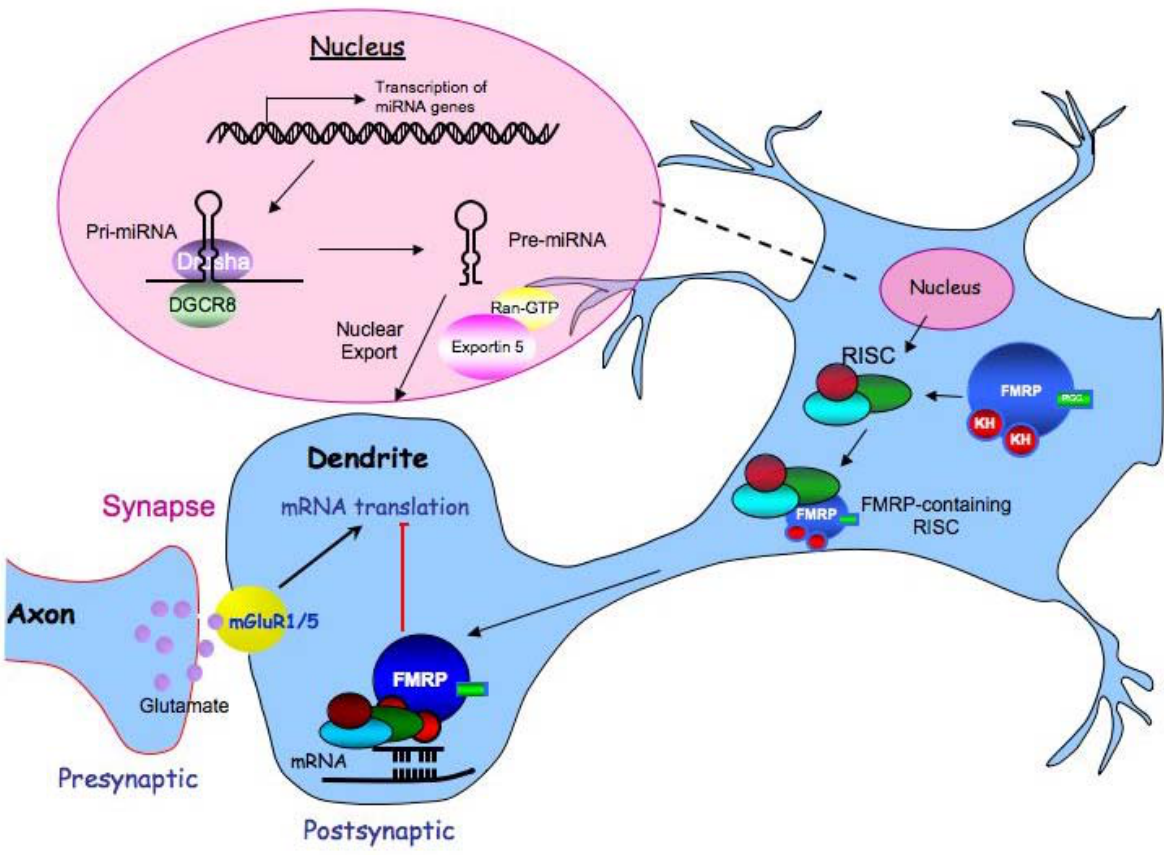
FIGURE 1. A model for FMRP-mediated translational suppression of mRNA targets via the miRNA pathway in the neuron. In the nucleus, miRNA genes are transcribed to generate primiRNAs, which are processed into the hairpin-structured pre-miRNAs by Drosha along with DGCR8. After being transported to the cytoplasm by Exportin 5, pre-miRNAs are further processed by Dicer to generate the duplex miRNA. Upon unwinding, one strand of the duplex is preferentially integrated into the RNA-induced silencing complex (RISC) and directs it to mRNA targets. FMRP forms a messenger ribonucleoprotein (mRNP) complex by interacting with specific RNA transcripts and proteins. At least some of the FMRP-mRNP complexes interact with RISC, which could regulate protein synthesis in the cell body of the neuron. In addition, FMRP- containing RISC could also be transported into dendrites to regulate local protein synthesis of specific RNAs in response to synaptic stimulation signals such as metabotropic glutamate receptor activation. miRNAs function as negative regulators of gene expression by targeting mRNAs for translational pairing to its target mRNAs, while in animals, miRNAs usually inhibit translation through imperfect